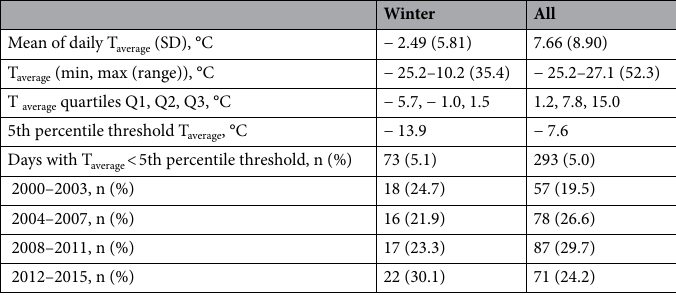
Table 2. Descriptive statistics of outdoor temperature (T) in Kaunas during the study years 2000–2015.